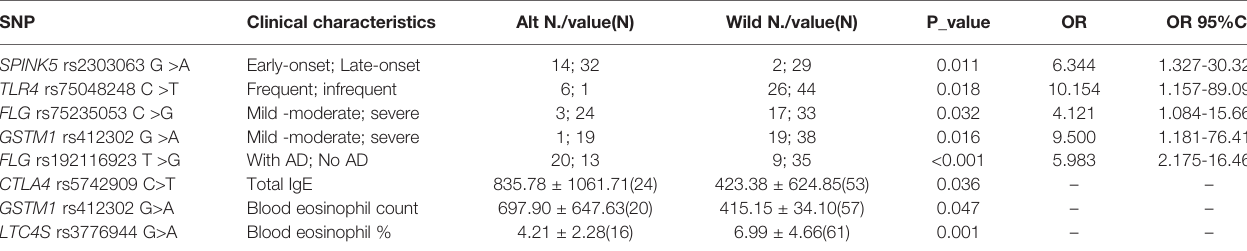
TABLE 3 | SNPs associated with clinical characteristics of EA